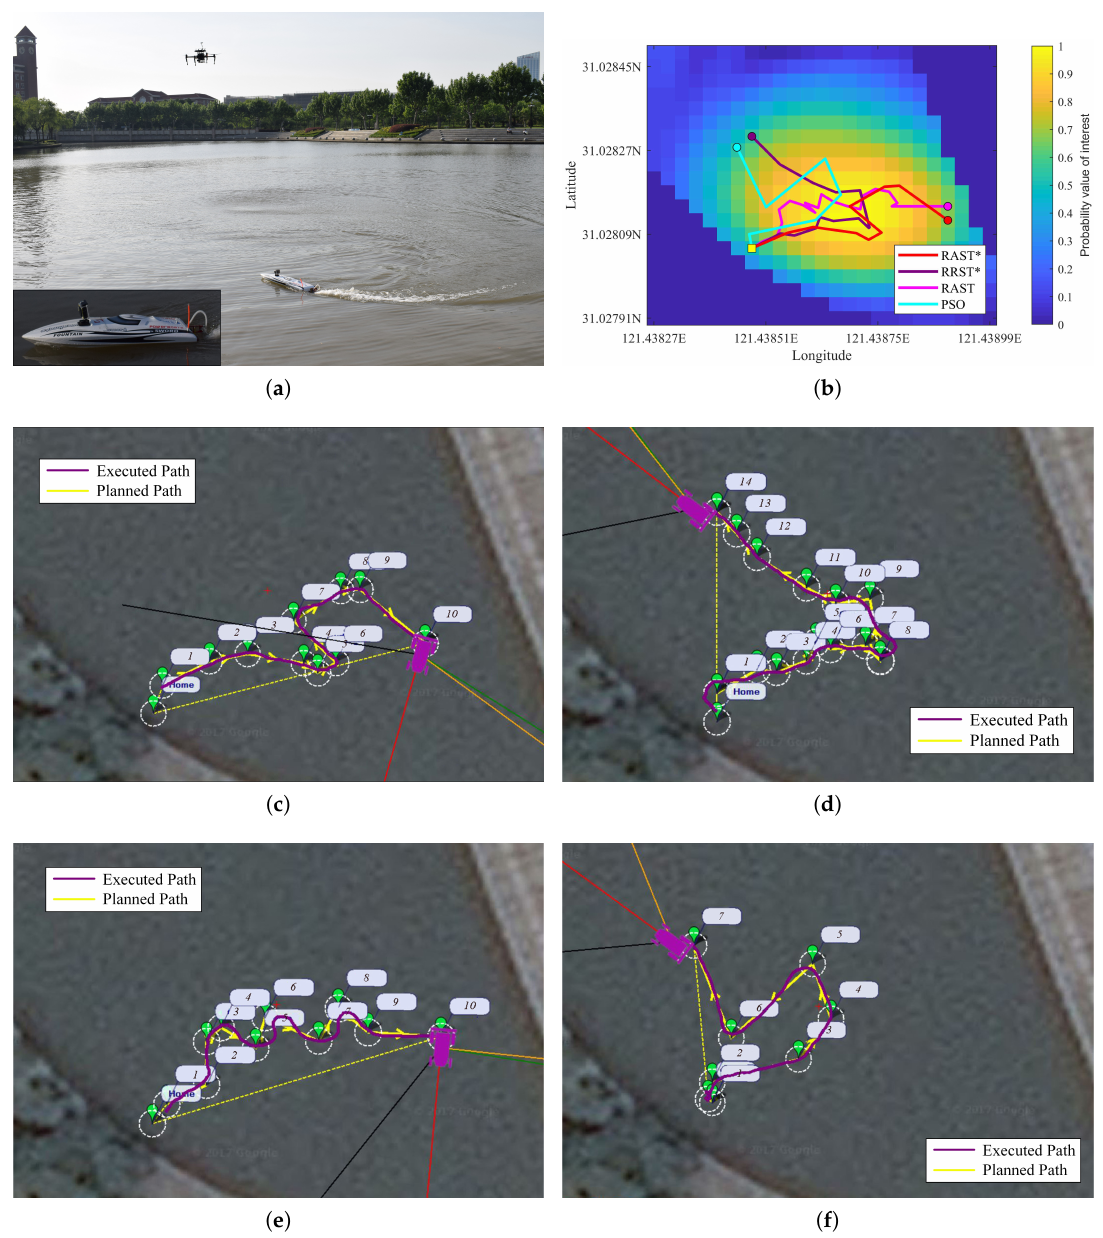
Figure 5. ( a ) Filed experiments of an ASV developed by Shanghai Jiao Tong University. ( b ) Numerical results of off-line paths produced by the four path planners. The background is the simulated utility map of Lake Zhiyuan. ( c ) Interface of the recorded executed path produced by the proposed RAST* path planner in Mission Planner. ( d – f ) Interface of the recorded executed path produced by RRST*, RAST, and PSO path planners in Mission